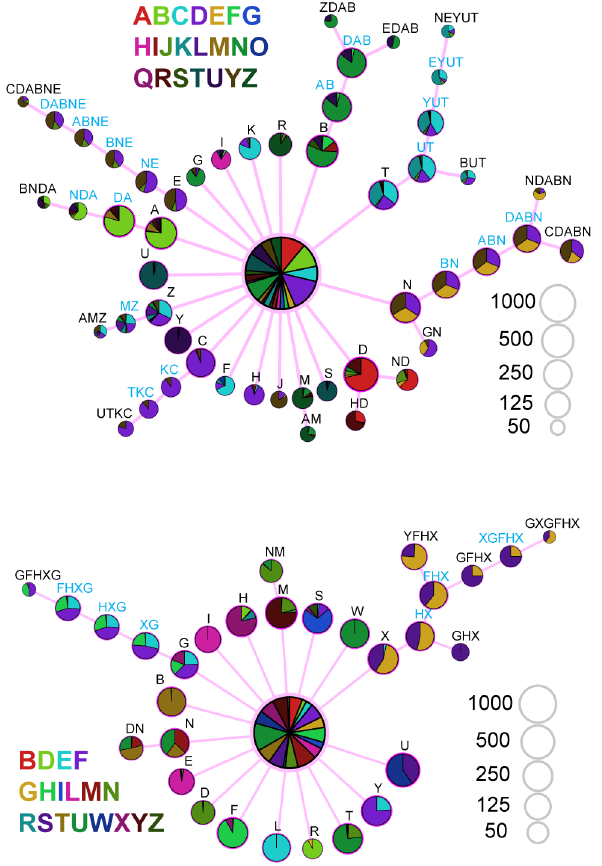
Figure 5. Prediction suffix trees (PSTs) reveal long-range structure in canary song. Letters are arbitrary labels for phrase types. PSTs were generated for all 6 birds (the other four are shown in Fig. S8 ). The length of the branch terminating in a given phrase type phrases back in the song to accurately predict the transition probabilities from the terminal node at the center. Each node is shown as a pie chart representing the outgoing transition probabilities from that sequence of phrases (for each bird, syllables are assigned arbitrary colors). The nodes are scaled according to their frequency. Nodes that can be grouped together (chunked) without significantly reducing the power of the model are labeled with blue text.